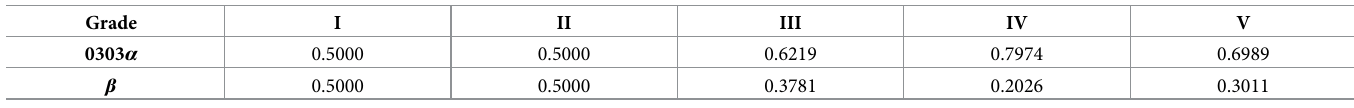
cloud to cloud. The larger the similarity value indicates the higher correlation between two clouds, and vice versa, the lower the correlation. From Table 6, the similarity value between the comprehensive evaluation cloud and the V-grade standard evaluation cloud calculated based on the three methods is the largest. This is Followed by the IV-grade standard evaluation cloud and the III-grade standard evaluation cloud. And the similarity between the remaining grades and the comprehensive evaluation cloud is 0. From the quantitative point of view, the automobile cockpit can be evaluated as comfortable. Analyzing the data in Table 6, the similarity values of its standard evaluation cloud and index evaluation cloud are: ECM (V > IV > III > II > I), MCM (V > IV > III > II > I), and EMCM (V > IV > III > II > I). That is, the direction of the results obtained using the three similarity cal- culation methods is the same. And the similarity value is the most similar to the standard eval-